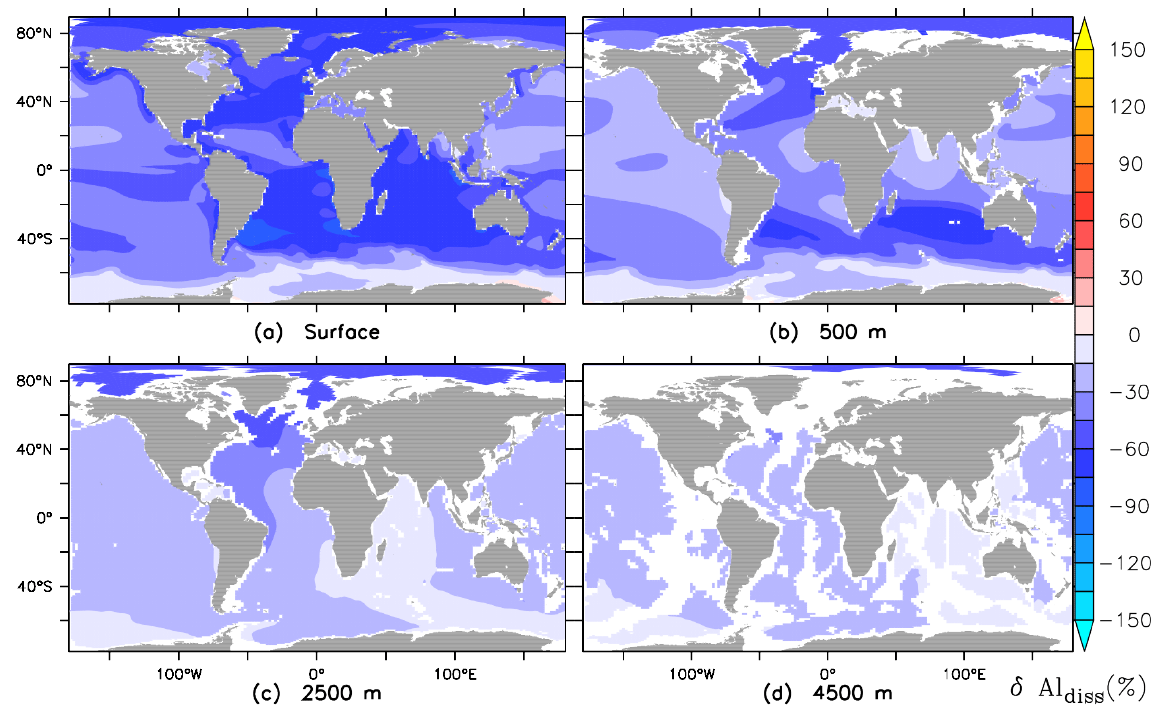
Figure 10. Relative difference of [ Al diss ] (%) between the simulation with biological incorporation (Incorp) and the reference simulation (RefDyn2) at four ocean depths (average over year 500).